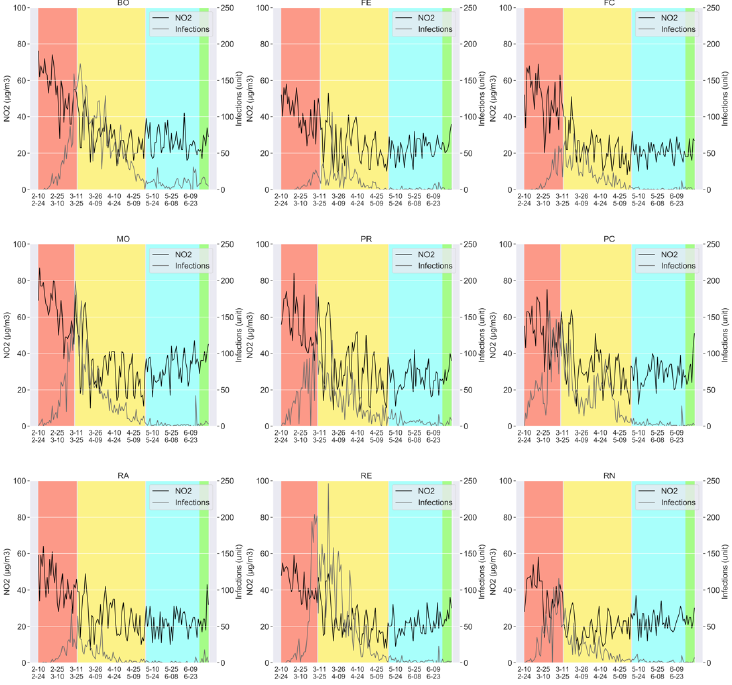
Figure 2. The dataset (I): infections, pollutant (NO 2 ), and phases.